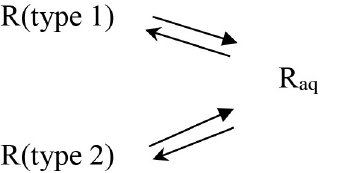
( R 2 of 0.94 and 0.99 for mono and bi-exponential models, (about 5 mg) and a slower one of about 18 min (about 10